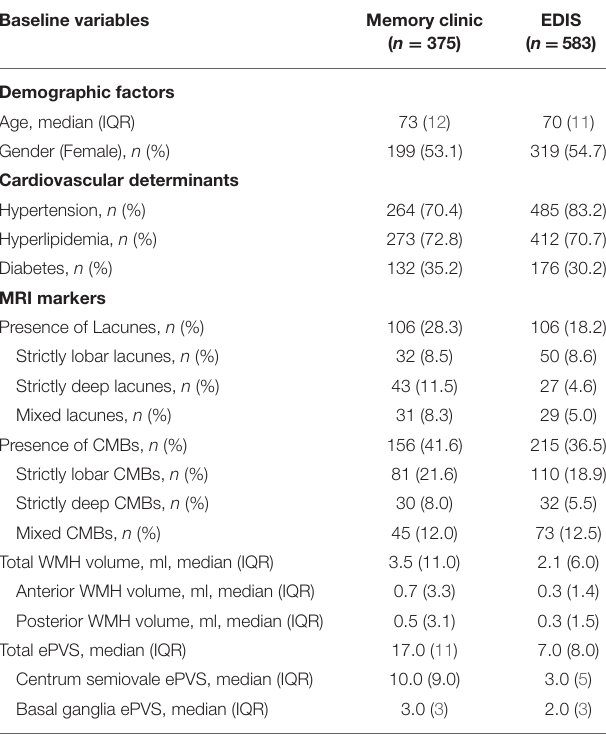
TABLE 1 | Characteristics of study participants.